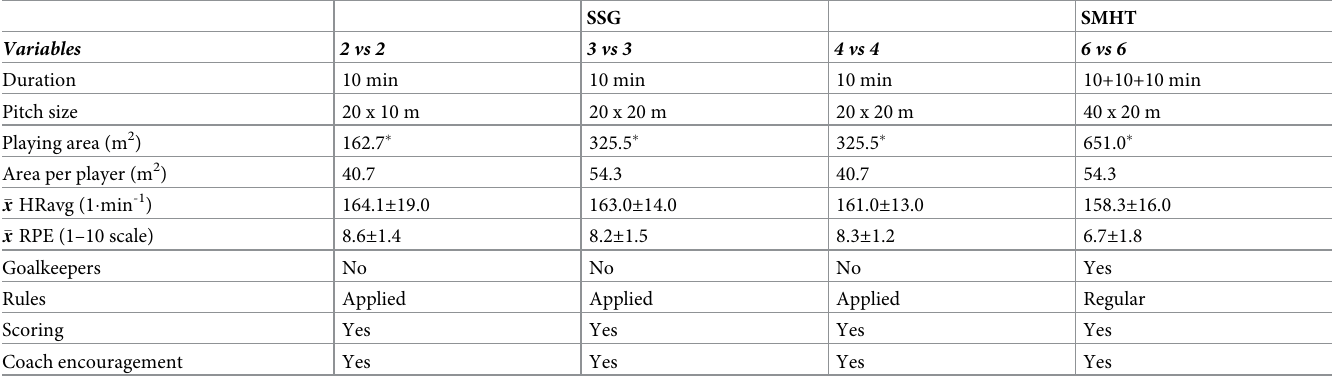
Table 1. Variables of SSG and SMHT training